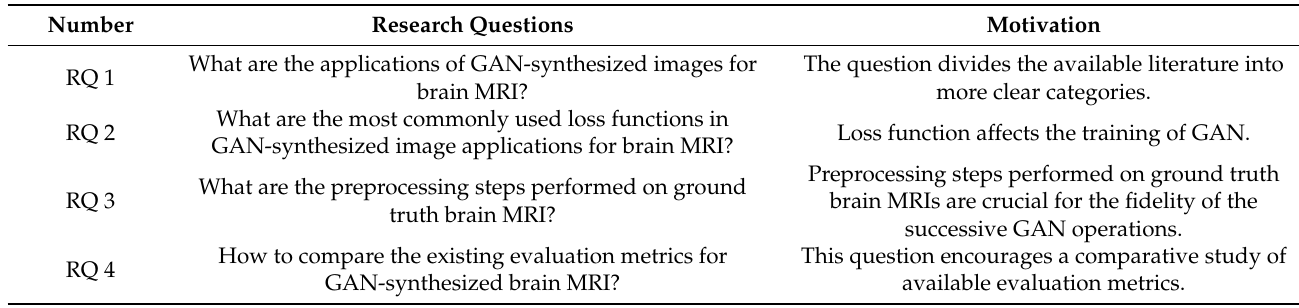
Table 2. Research questions for this SLR.